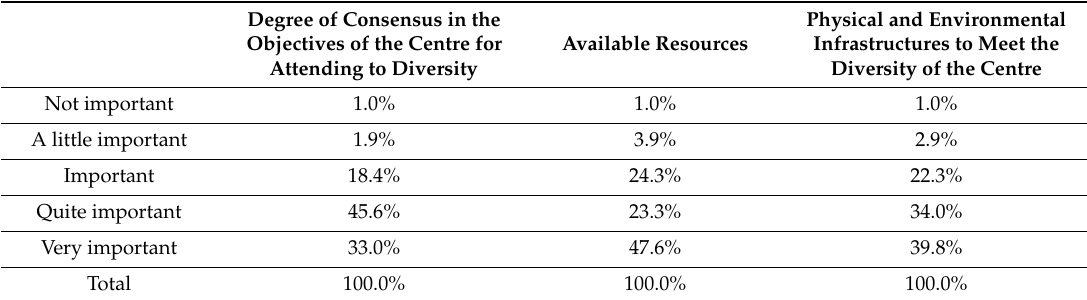
Table 3. Definition of the improvement strategy.